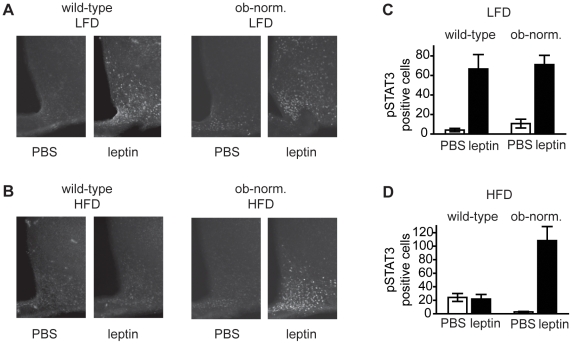
STAT3 phosphorylation in response to acute leptin injection.
A. Staining for pSTAT3 in the mediobasal hypothalamus of mice on a low-fat diet given an intraperitoneal injection of either leptin or vehicle. B. Staining for pSTAT3 in the mediobasal hypothalamus of mice on a high-fat diet given an intraperitoneal injection of either leptin or vehicle. C. Quantitation of pSTAT3 positive cells in the arcuate nucleus for mice on a low-fat diet. D. Quantitation of pSTAT3 positive cells in the arcuate nucleus for mice on a high-fat diet.